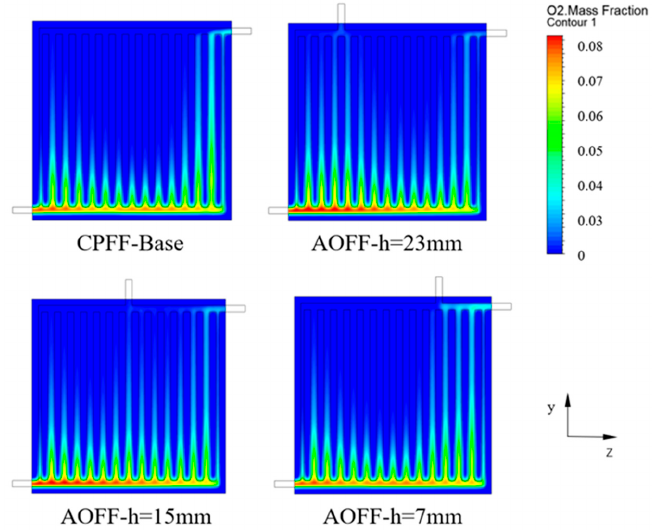
Figure 6. Oxygen mass fraction on the cathode CL–GDL interface for the CPFF pattern and AOFF patterns at Vcell = 0.5 V.